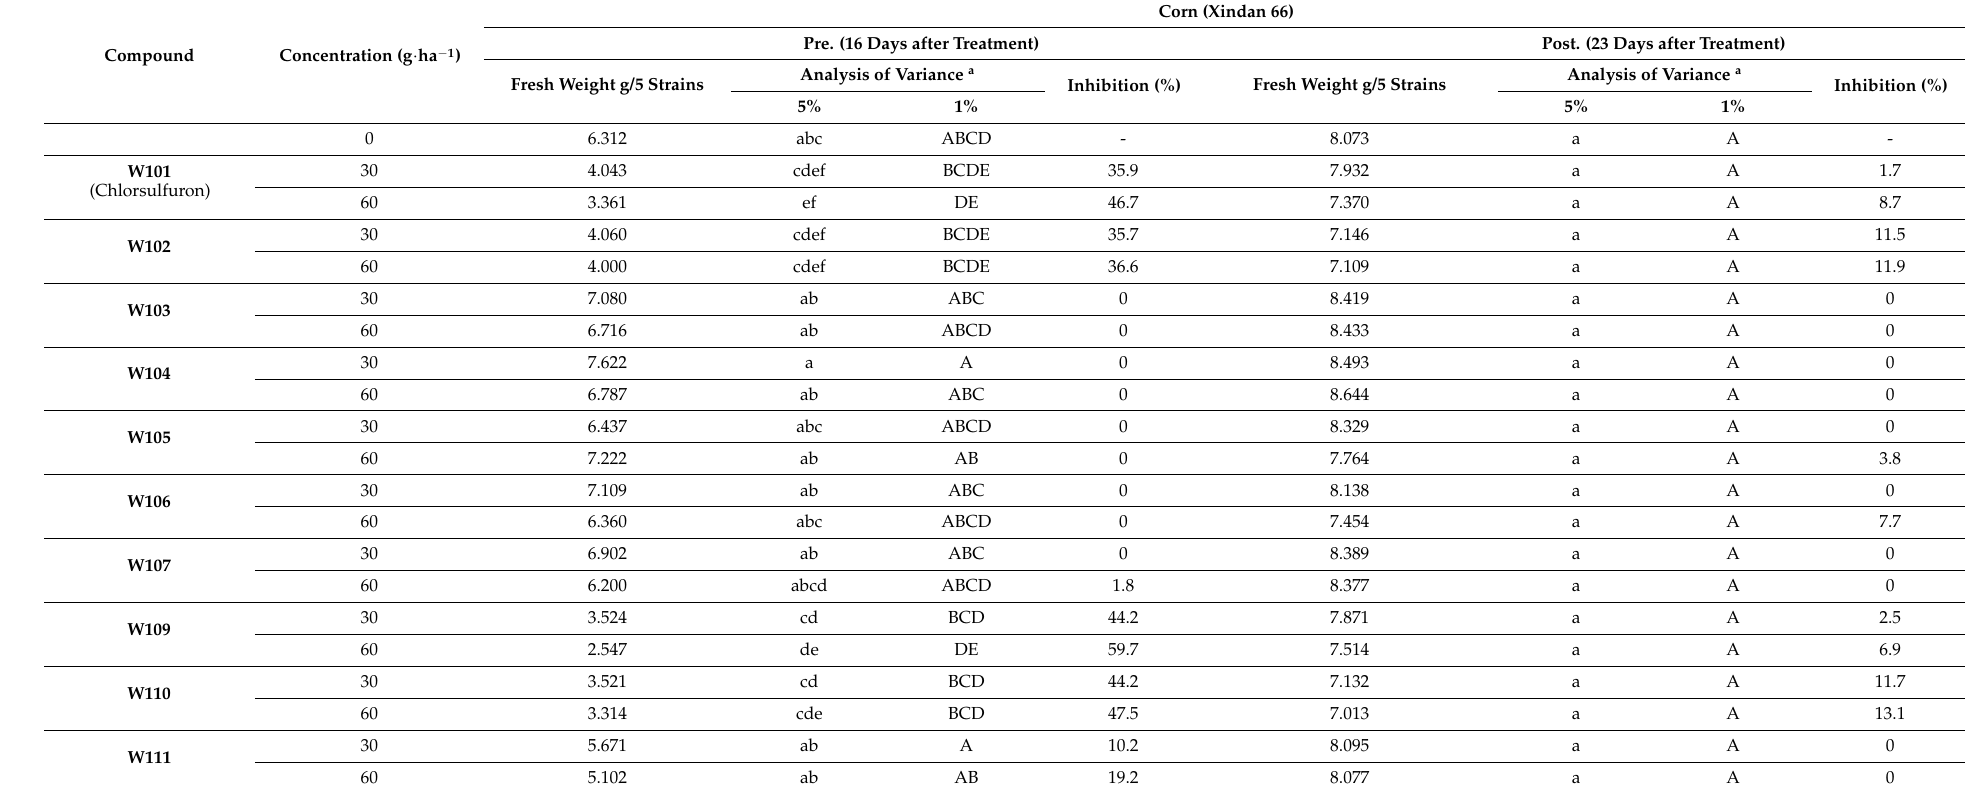
Table 6. Crop safety of target compounds on